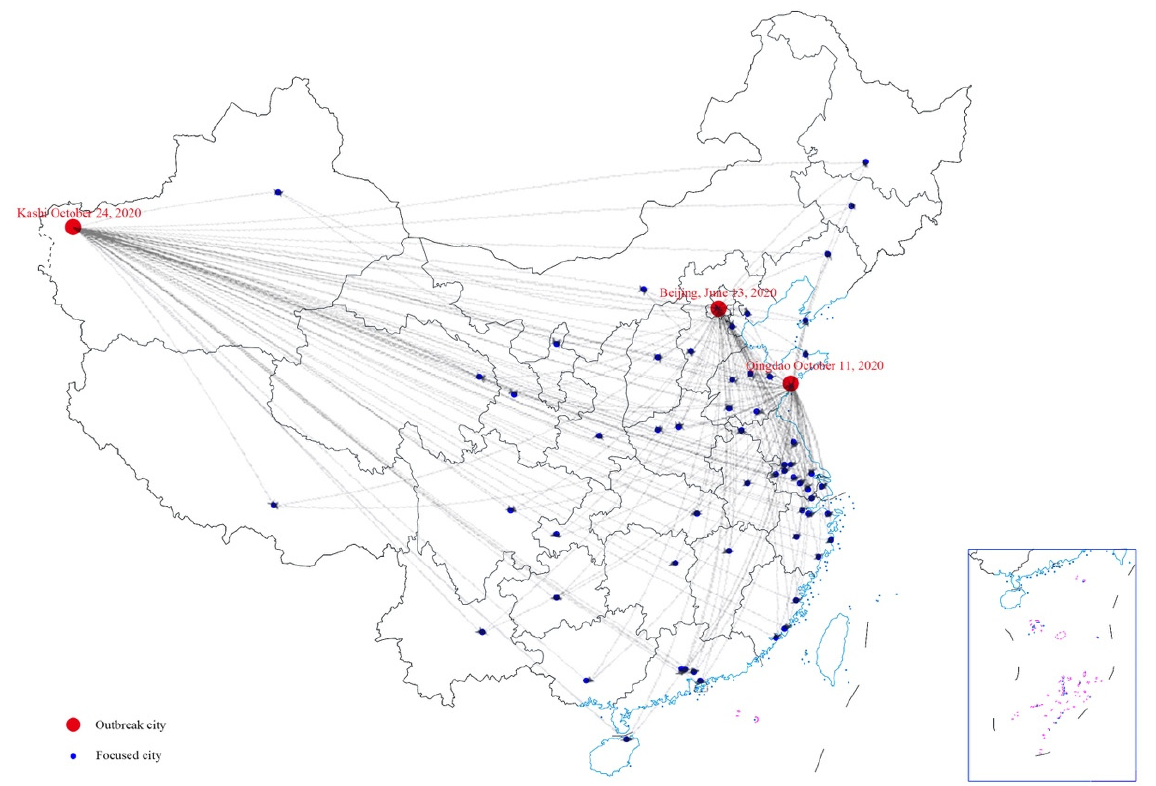
Figure 1. Sketch map for the psychological spillover effect of outbreak events.